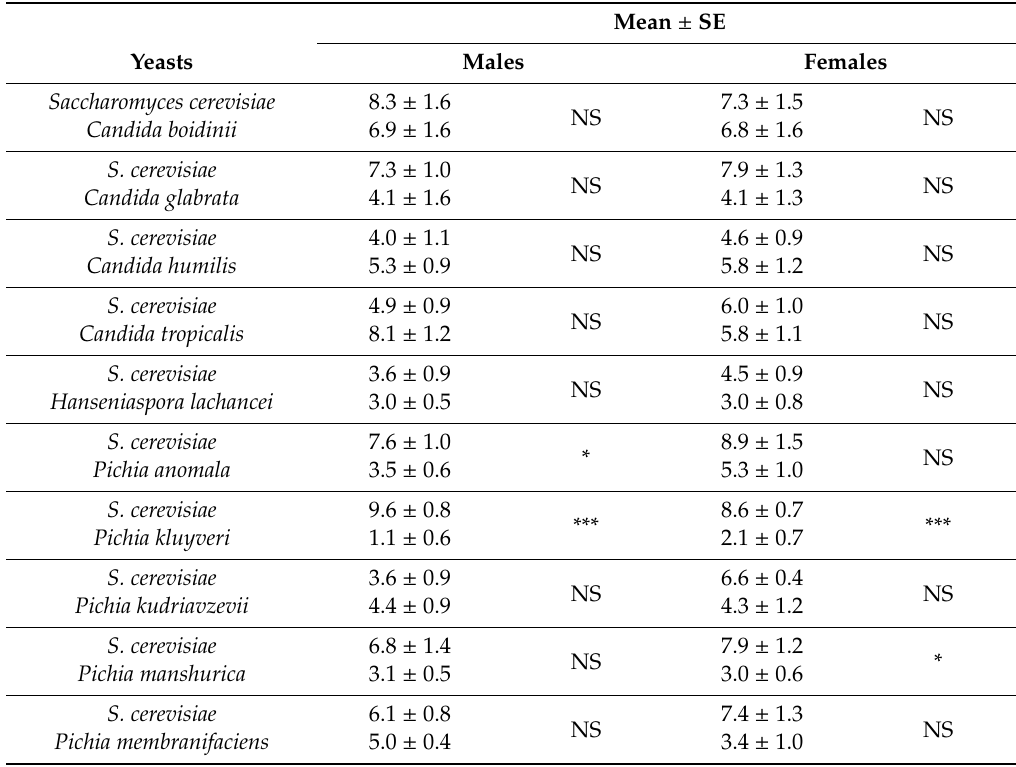
Table 3. Mean numbers of trapped males and females in pairwise comparisons of the reference yeast Saccharomyces cerevisiae (Tradi-Pan-Sc) with di ff erent species of Candida , Hanseniaspora , and Pichia grown in sucrose